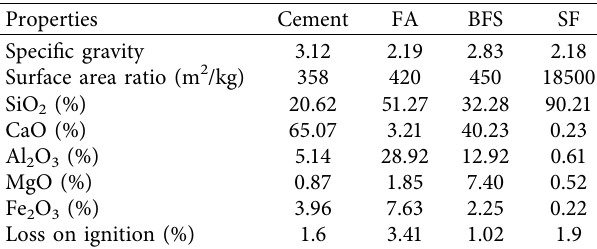
Table 1: Properties and main chemical compositions of cement and mineral